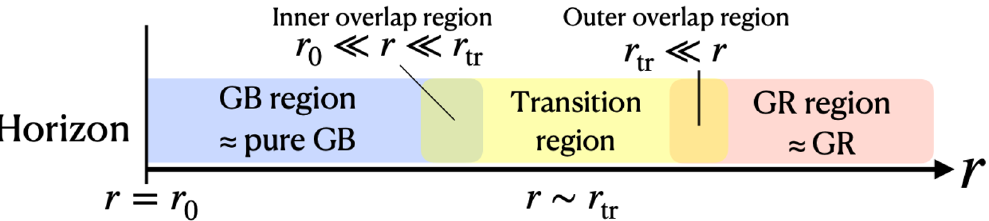
Figure 1 . Two separate regions in EGB black holes at large α